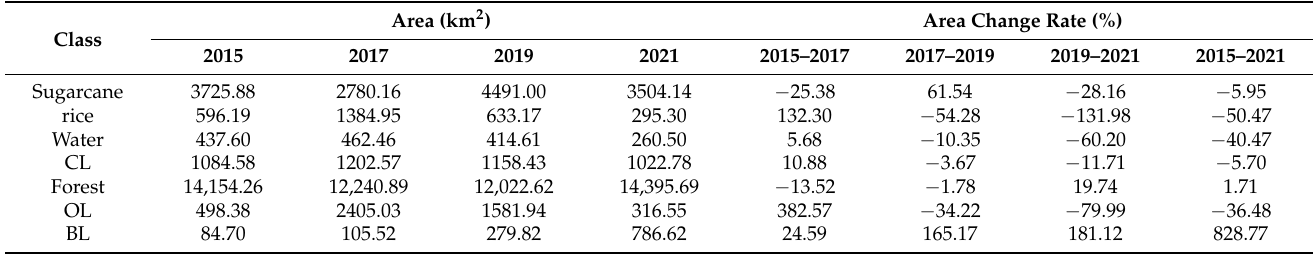
Table 10. Land use type changes in the study area for different periods from 2015 to